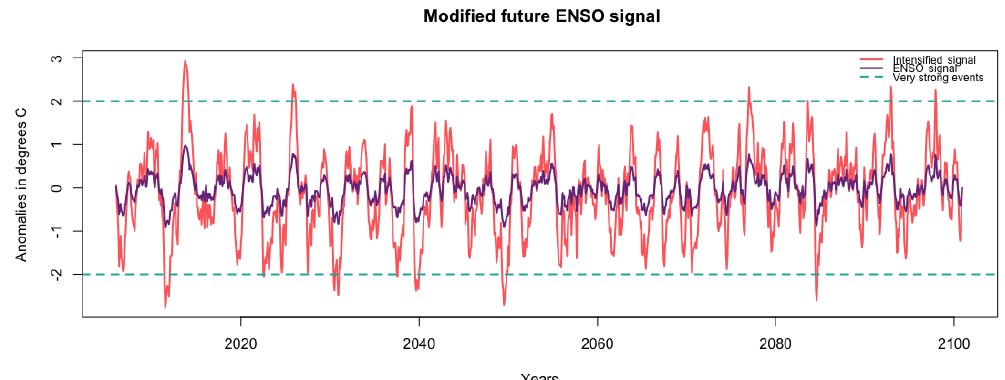
Figure A3. Intensified ENSO signal. Purple line: future ENSO signal retrieved from GCM outputs for the 2006–2100 period. Red line: intensified signal such that anomalies peak as strongly as recorded amplitudes ( ± 2.0 ◦ C). The dashed line marks the very strong ENSO event